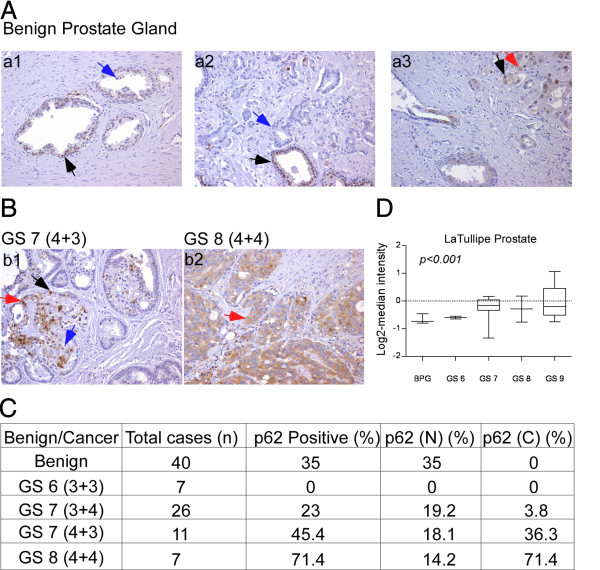
p62 expression in human prostate cancer (PCa) samples. (A and B) immuno-histochemical staining for p62 in PCa tissue microarrays. Black arrow: nuclear p62; red arrow: cytoplasmic; blue arrow: no staining (a1), benign prostate tissue with nuclear p62 staining; (a2), benign prostate tissue with nuclear p62 staining (a3), benign prostate tissue displaying nuclear p62 staining and PCa with cytoplasmic staining; (b1), PCa Gleason score (GS 4 + 3) 7 with both nuclear (black arrow) and cytoplasmic (red arrow) staining; (b2), PCa Gleason score (4 + 4) 8 with cytoplasmic staining (red arrow). (C) Nuclear (N) and cytoplasmic (C) p62 expression in benign and various GS (D) mRNA expression analysis in benign prostate tissue (benign prostate hyperplesia) and various GS human PCa samples from the Oncomine database (p < 0.001).